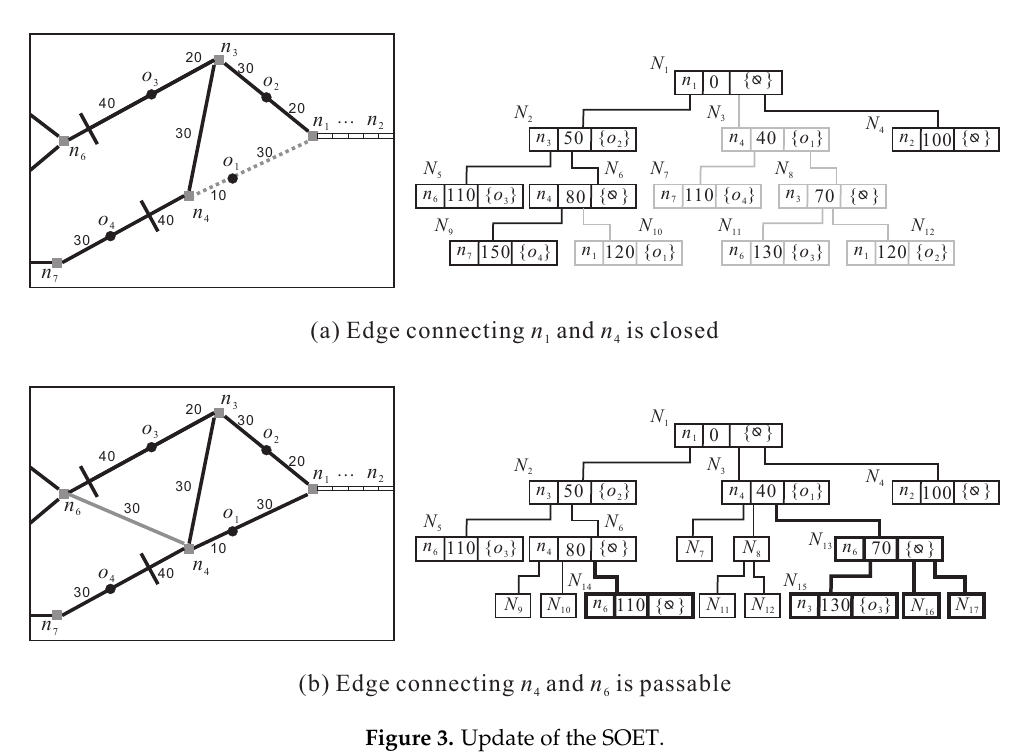
Figure 3. Update of the